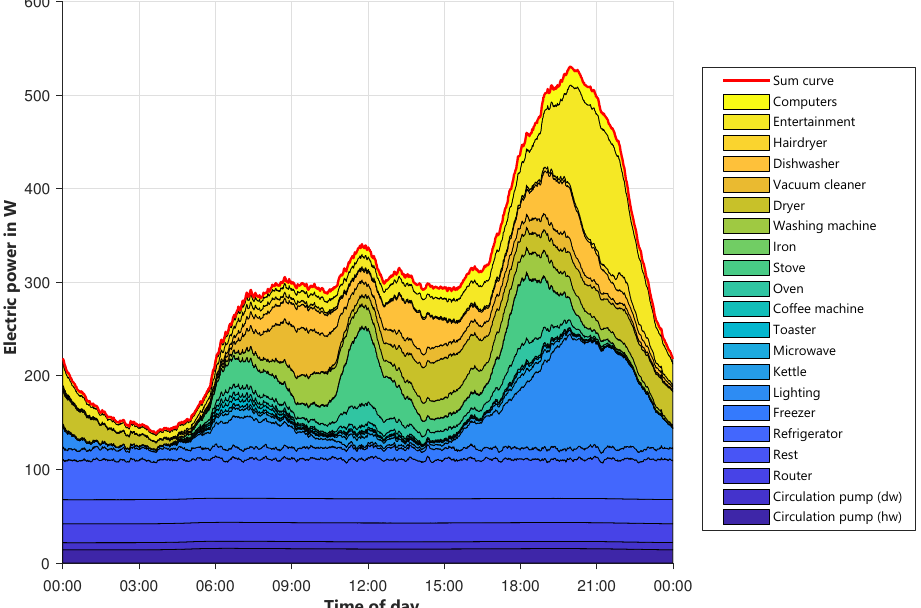
Figure A4. Layered load profiles of devices for type of day